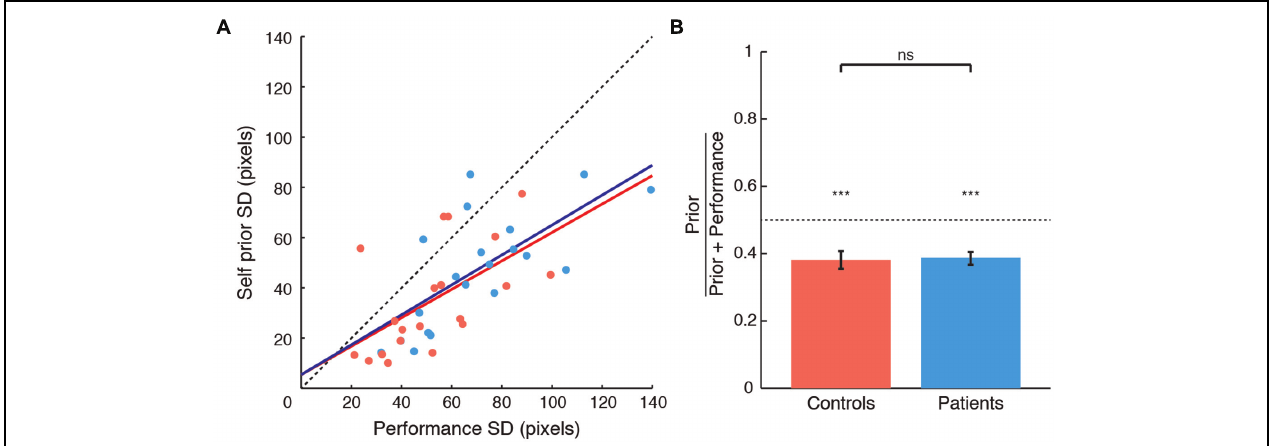
FIGURE 2 | Comparison between Self priors across groups. (A) SDs of Self priors plotted against SDs of performance errors for patients (blue circles and regression line) and controls (orange circles and regression line). Data points lie below the line of equality (black dashed line) in 34 of the 40 subjects. (B) Prior SDs normalized to performance error SDs, plotted for patients (blue) and controls (orange). For both groups, the SDs of priors were smaller than the SDs of performance errors. No difference was found across groups. Significance level indicated by ∗∗∗ p < 0.001.